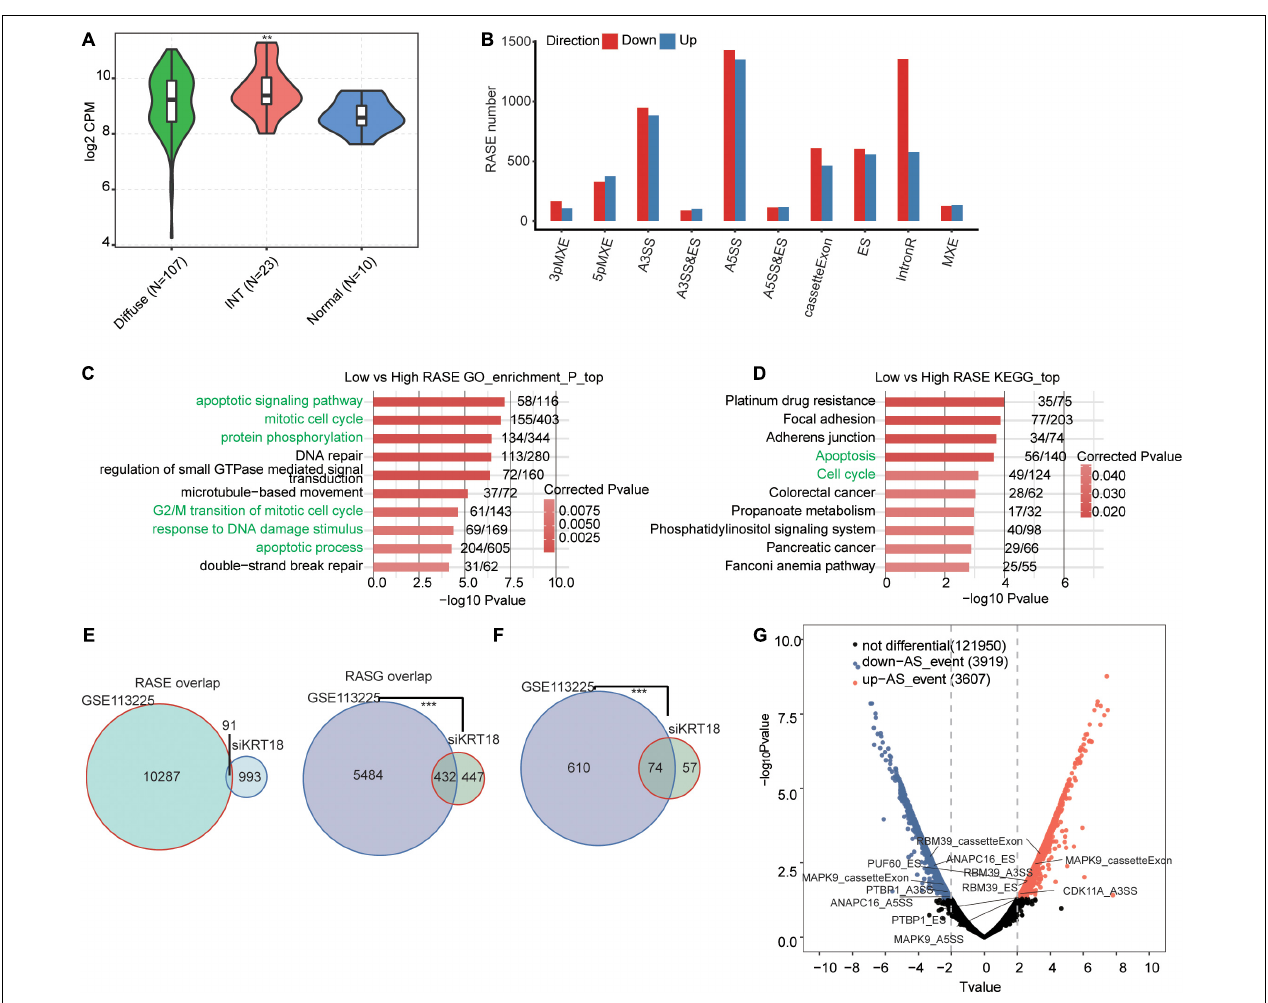
FIGURE 4 | KRT18-regulated alternative spliced genes in AGS cells were similarly regulated in a KRT18-dependent manner in gastric cancer samples. (A) Violin plot of expression of KRT18 in 140 GC samples from GEO database (GSE113255), including 10 normal samples, 23 intestinal-type GC samples, and 107 diffuse-type GC samples. (B) Classification of deregulated alternative splicing events in gastric carcinoma samples with low expression of KRT18 ( KRT18 -low group) compared to KRT18 highly expressed samples ( KRT18 -high group). (C) The top 10 GO biological processes terms and (D) KEGG functional pathways of deregulated alternative spliced genes between KRT18 -low and -high gastric carcinoma samples. (E) Venn diagram shows the overlapping of all RASEs and RASGs in AGS cells and GC samples. (F) Venn diagram shows the overlapping of selected cancer-related RASGs in AGS cells and GC samples. *** p < 0.001, Hypergeometric test. (G) The volcano plots of RASGs in GC samples, differentially up-regulated ASEs ( T -value ≥ 2, p < 0.01) are labeled red, whereas differentially down-regulated ones ( T ≤ 0.5, p < 0.01) are labeled